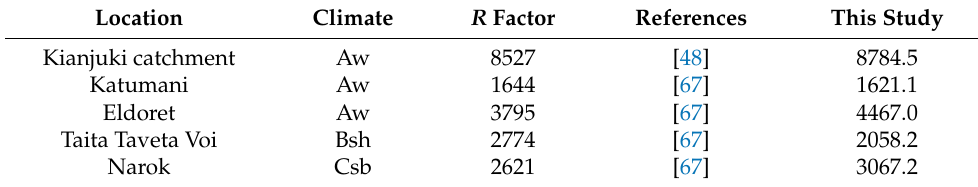
calculations in Kenya.